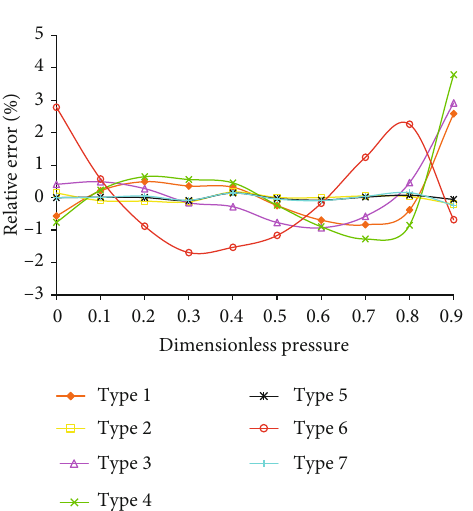
Figure 5: Relative error analysis of in fl ow performance equation fi tting for seven types of 30 ° inclined wells.